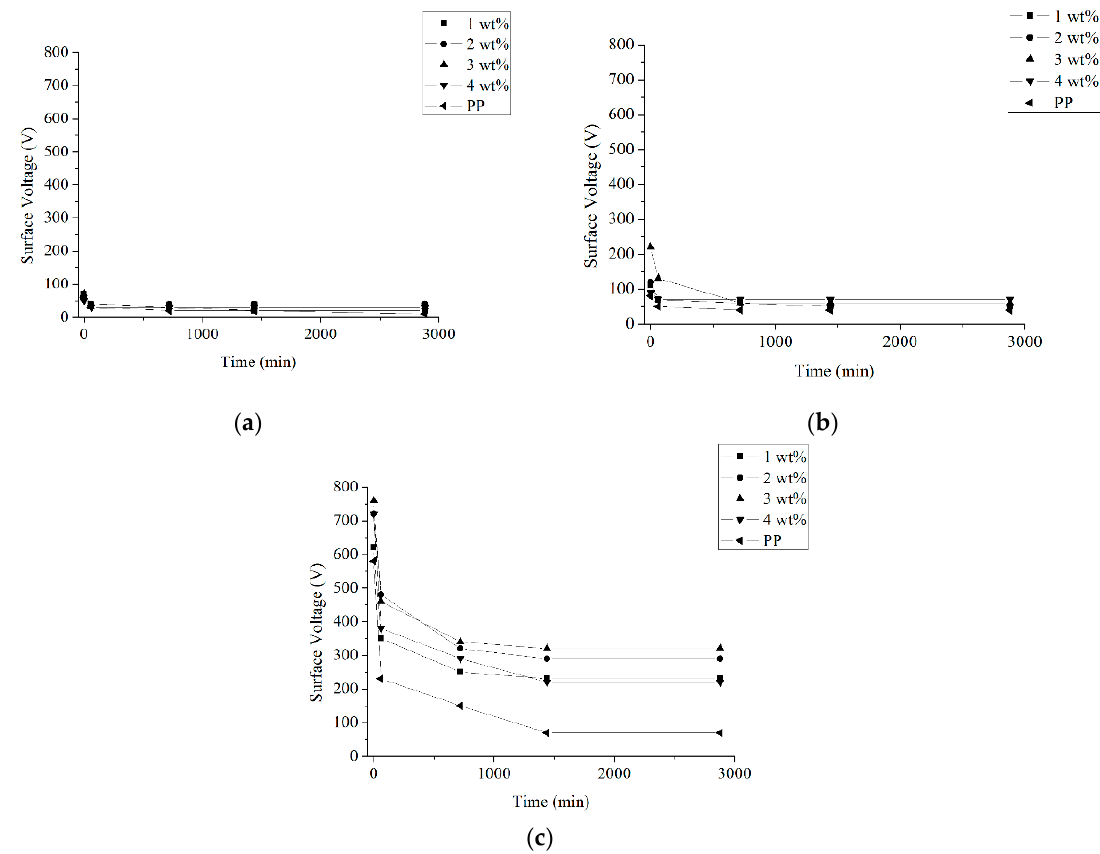
Figure 3. Surface voltage of electret melt-blown fabrics as related to the ratio of TiO 2 (1, 2, 3, and 4 wt%) and electric field intensities of ( a ) 1.5, ( b ) 2.0, and ( c ) 2.5 kV/cm. and electric field intensities of ( a ) 1.5, ( b ) 2.0, and ( c ) 2.5 kV /